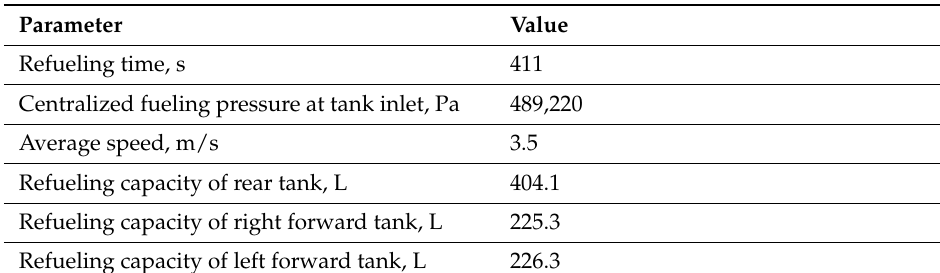
Table 3. Simulation data of the refueling mode.